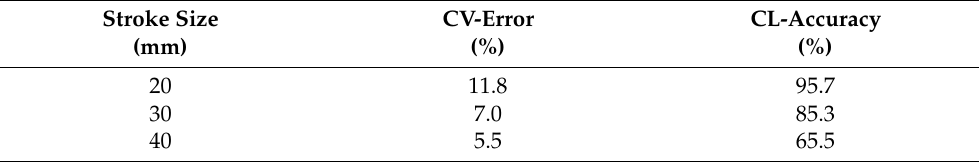
Table 7. Effect of stroke sizes on classification accuracy for DataSet1 at 1 GHz.